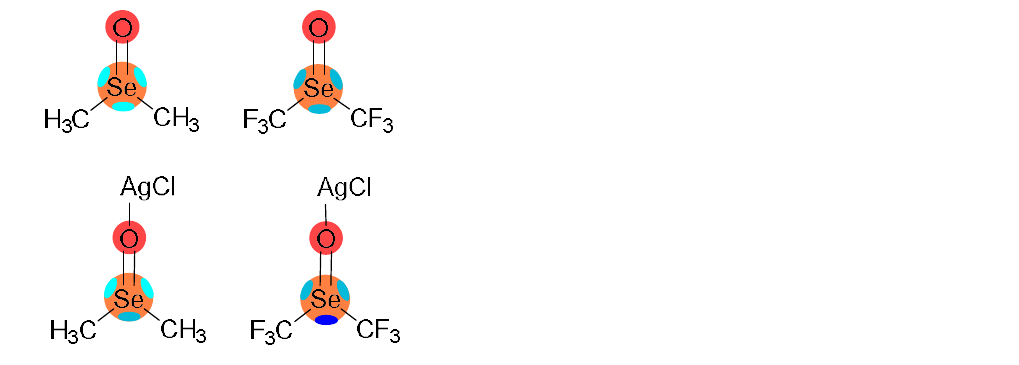
Figure 1. Four selenoxides theoretically studied in this work with a schematic representation of the σ-holes.